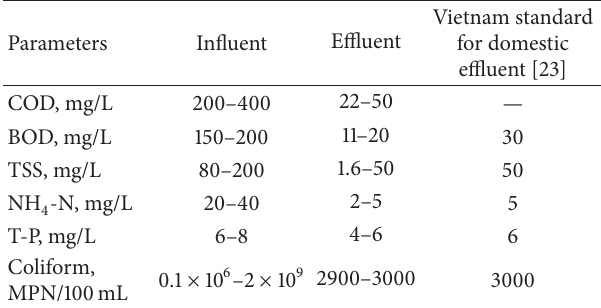
household latrines, onsite advanced treatment Johkasou, and centralized conventional aerobic treatment. The emission